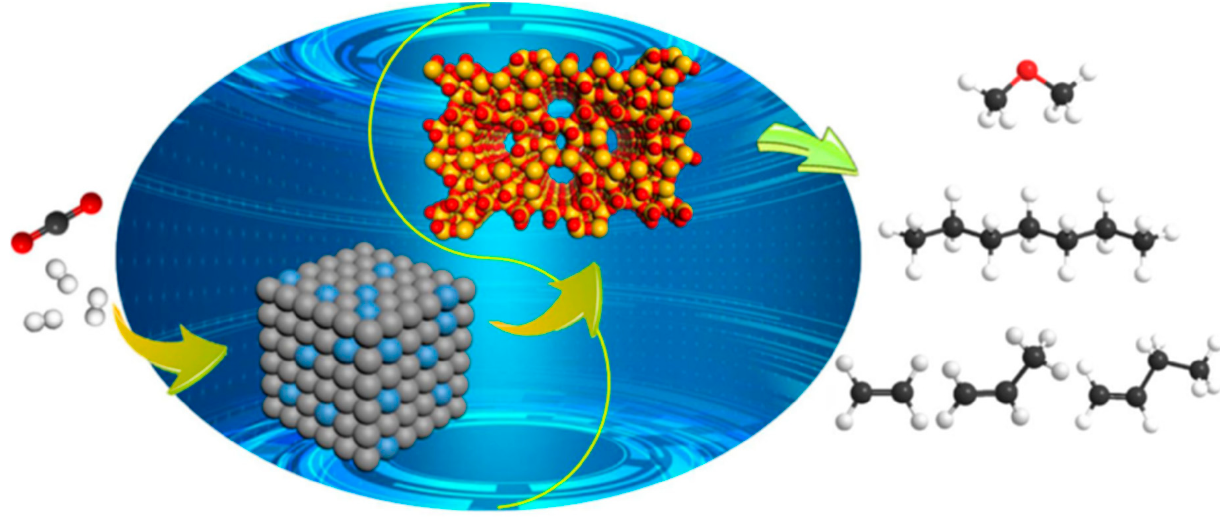
Figure 12. Schematic reaction mechanism of direct CO 2 hydrogenation to C2+ products over bifunctional catalysts. Reproduced with permission from ref. [59], open access Nat. Commun. 2021.